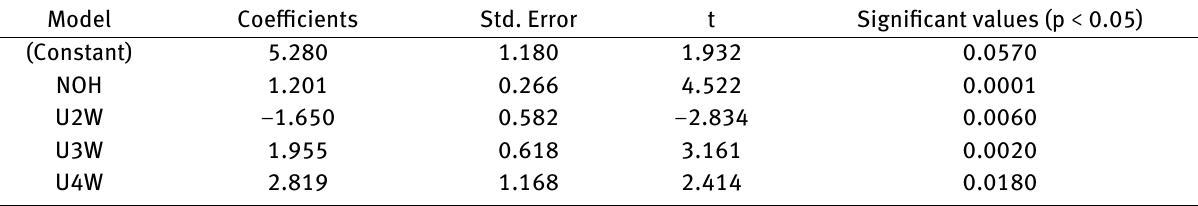
Table 7: Regression variable results for 8 hours Model